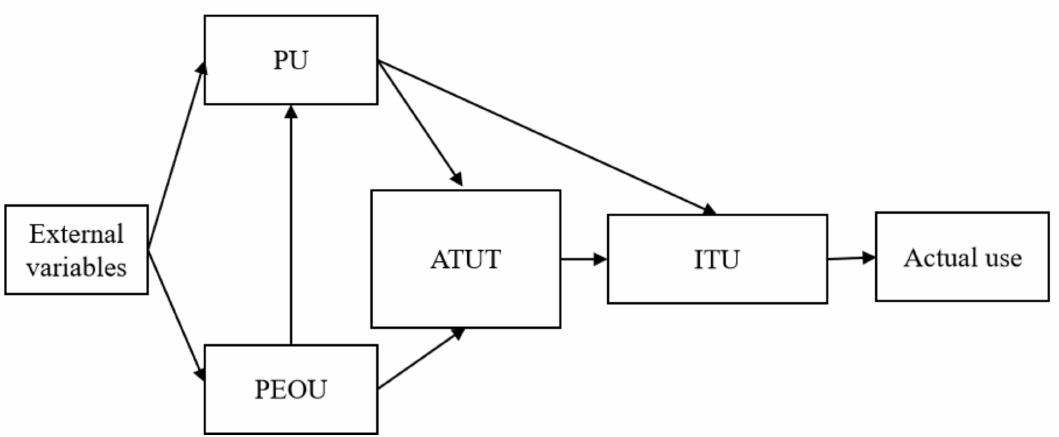
Figure 1. TAM by Davis, Bagozzi, and Warshaw